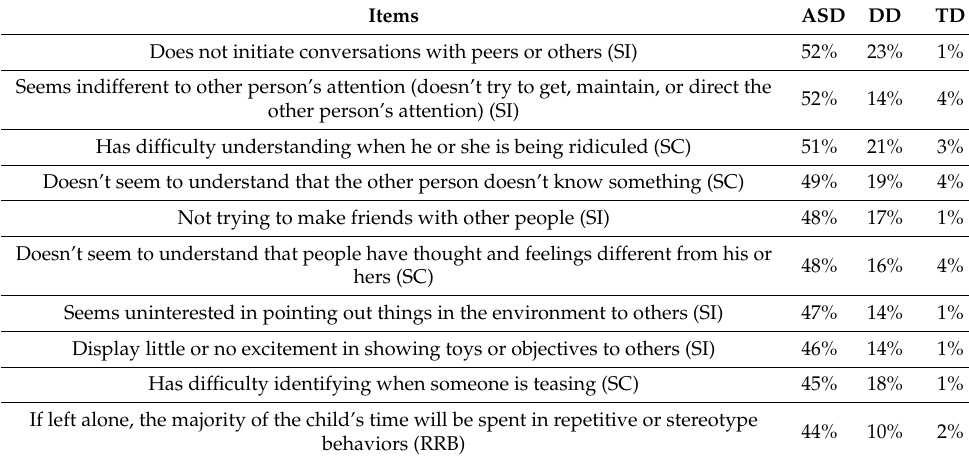
Table 1. The percentage of children in each grouping rated as “likely” for AS on the ten highest items (and their subscales). Items ASD DD TD Does not initiate conversations with peers or others (SI) 52% 23%